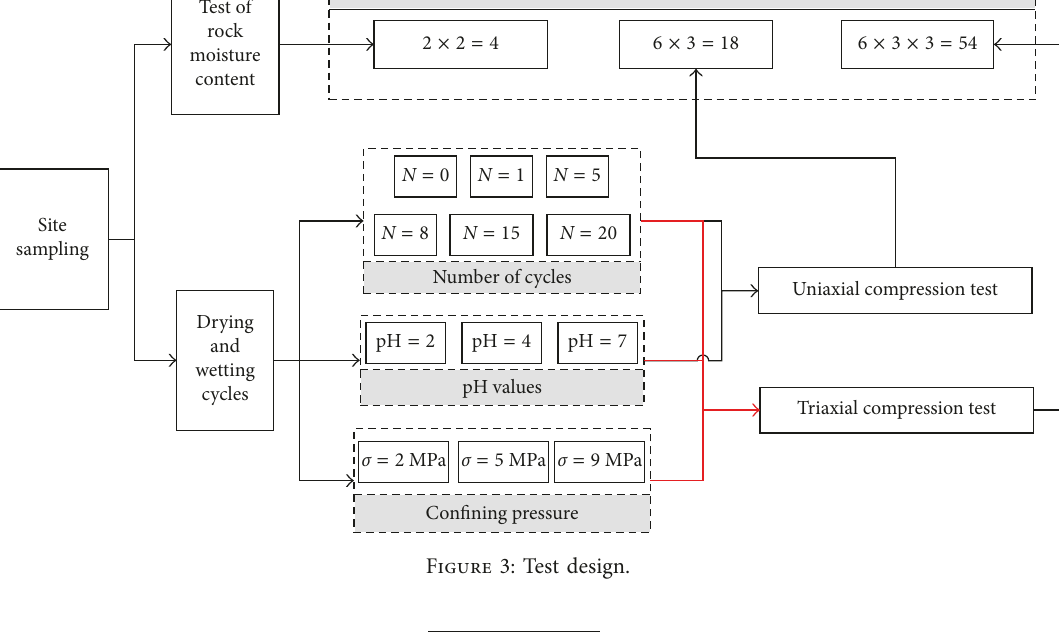
Figure 3: Test design.